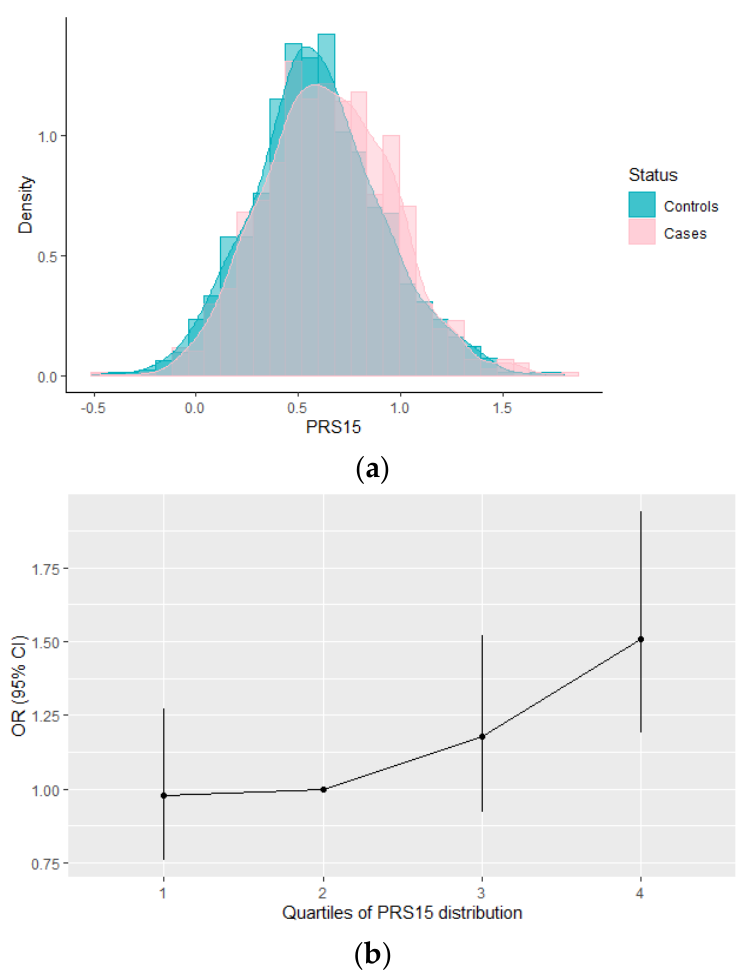
Figure 1. Distribution of the PRS 15 and its association, by quartiles, with breast cancer risk in the MASTOS study. ( a ) Distribution of the PRS 15 in controls (blue) and in cases (pink) in Cypriot women. The average PRS 15 was higher in cases compared with the controls ( b ) OR (95% CI) for breast cancer risk by quartiles of PRS 15 risk distribution, using as reference the 2nd quartile (25–50%). Women in the fourth quartile had a significant increased breast cancer risk compared with those in the 2nd quartile.